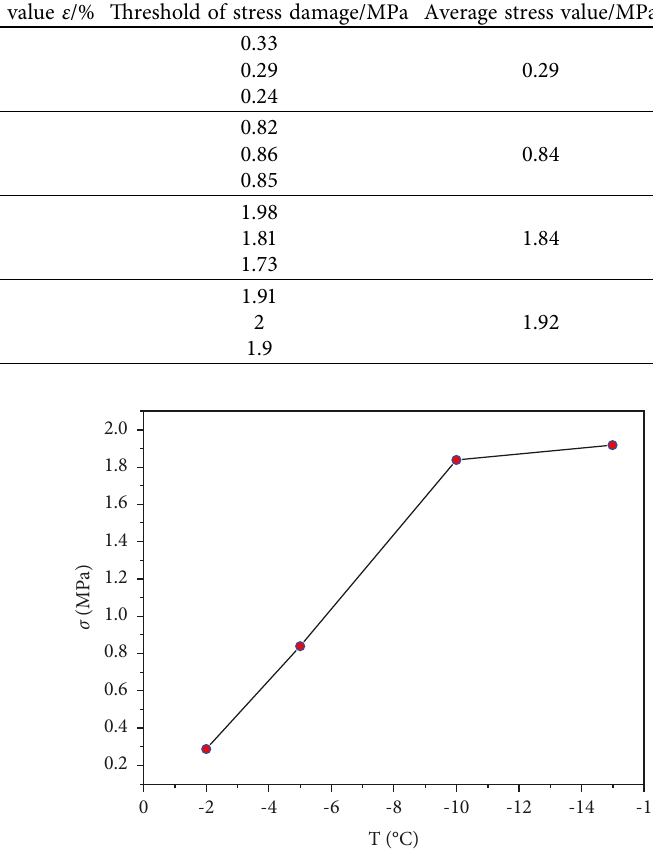
Figure 9: Threshold value of stress damage at different